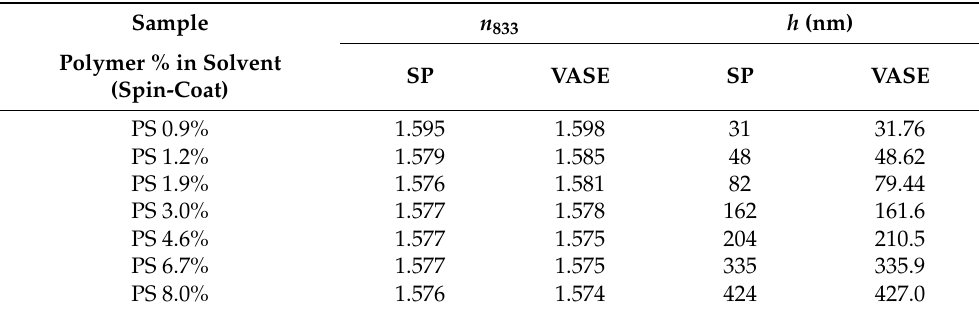
Table 2. Comparison of n and h of PS films, obtained with the proposed spectrophotometric method (SP) and with VASE.